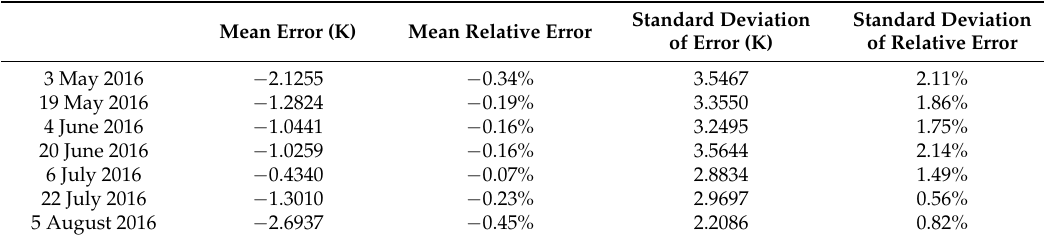
Figure 4. Histogram of the difference between retrieved land surface temperature (LST) and MODIS LST products. Table 4. Statistics obtained from the comparison of retrieved LST against observed Landsat 8